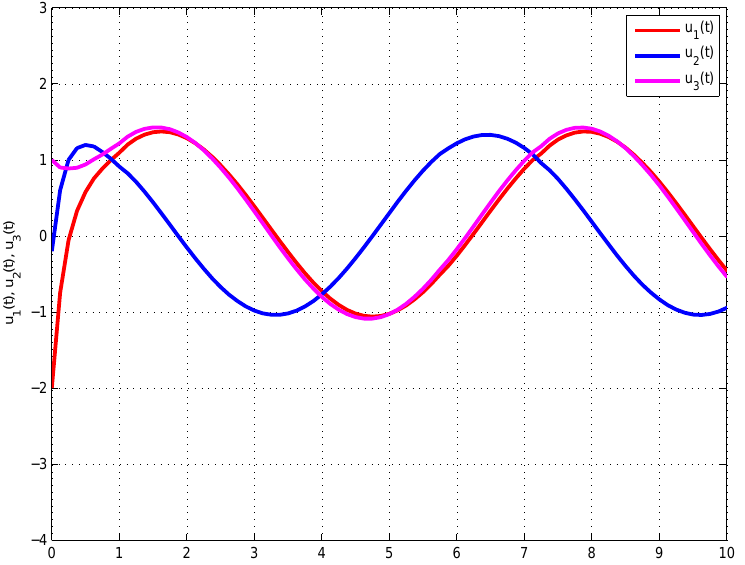
Figure 1. The time responses of the states u 1 ( t ) , u 2 ( t ) and u 3 ( t ) of system (70) for the external inputs x ( t ) = [ 1 + sin t ,1 + cos t ,1 + sin t ] T in Example